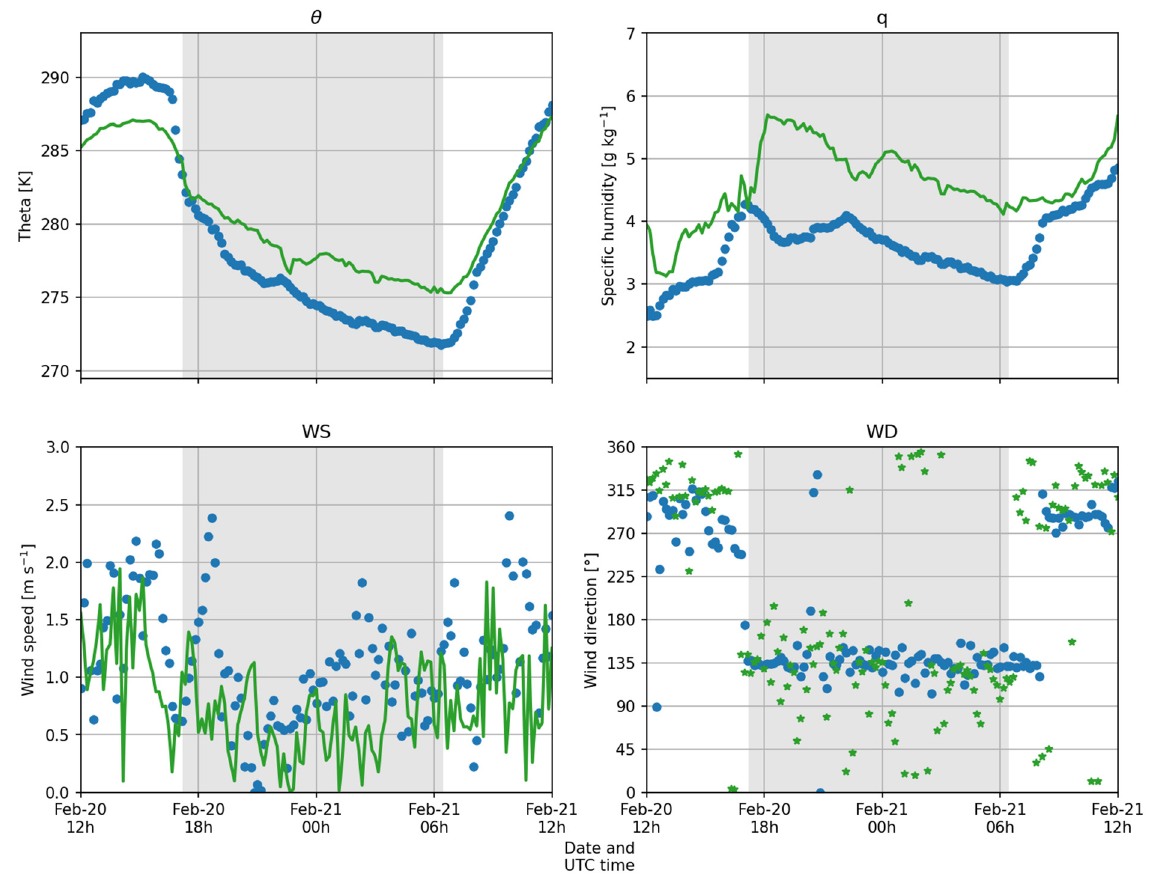
Figure 9. Time series of potential temperature ( θ ), specific humidity (q), wind speed (WS), and wind direction (WD) at the MET 01 site, observed (blue) and simulated (green).